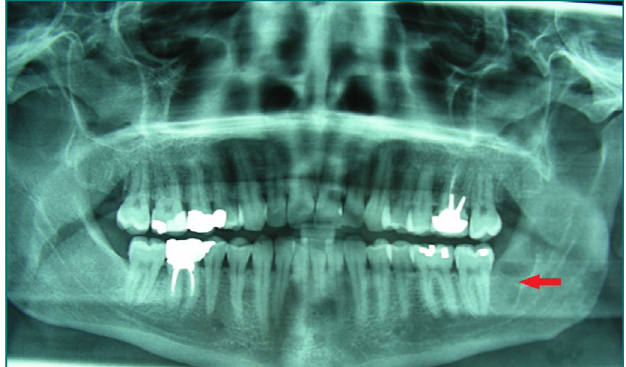
Fig. 2. Panoramic radiograph.